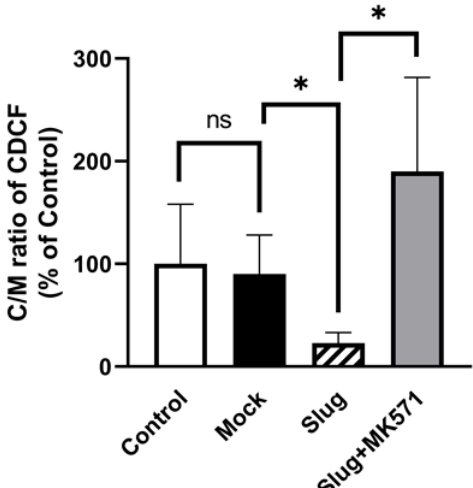
Figure 4. Uptake of CDCF in Slug-transfected HCC827 cells, Mock-transfected cells, and Control